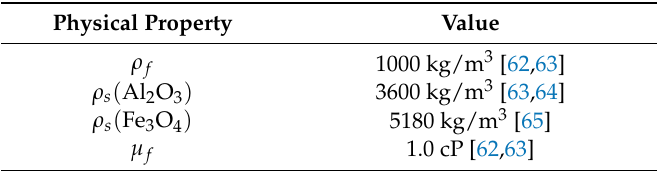
Table 2. Physical properties of the water–Al 2 O 3 and water–Fe 3 O 4